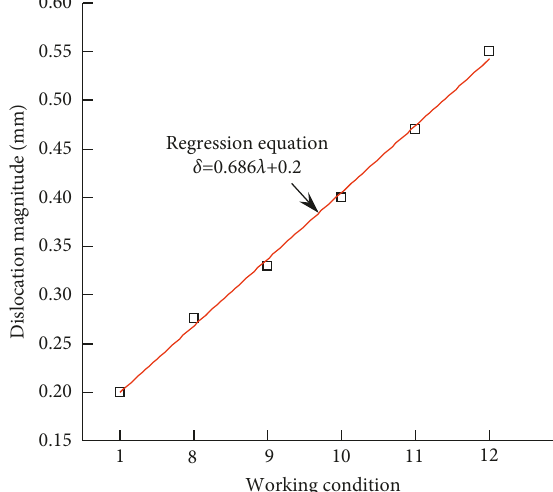
Figure 20: The settlement of the monitored section under torsion.